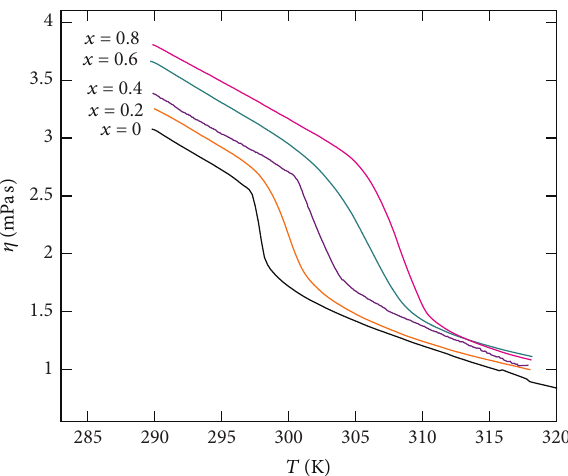
Figure 10: Temperature dependence of the calculated effective viscosity 𝜂 of a supported vesicle layer of DMPC + DPPC mixtures onagold-coatedQCM-Dquartzsensor. 𝑥 referstothemolefraction of DPPC.